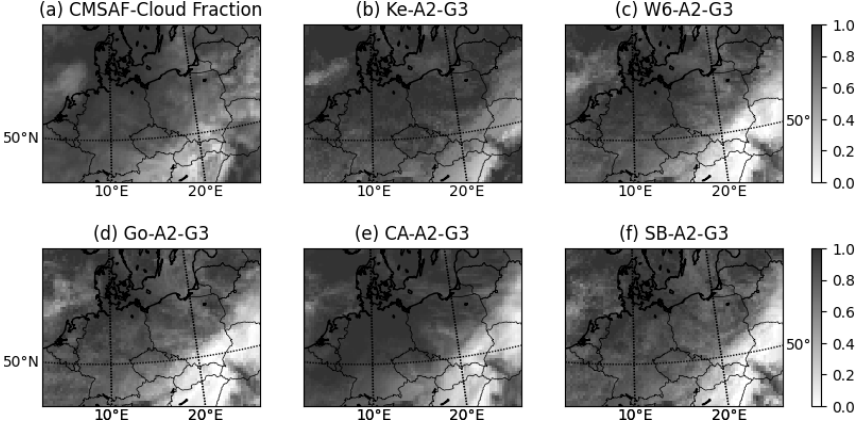
Figure 10. Average cloud cover fraction for 36h of (a) satellite data and simulation by different microphysics, including (b) Kessler, (c) WSM6, (d) Goddard (e) CAM5.1, and (f) SBU–YLin. All the simulations are configured with Grell-3D and ACM2 PBL physics, which performed a more skilled prediction than any other combination from 21